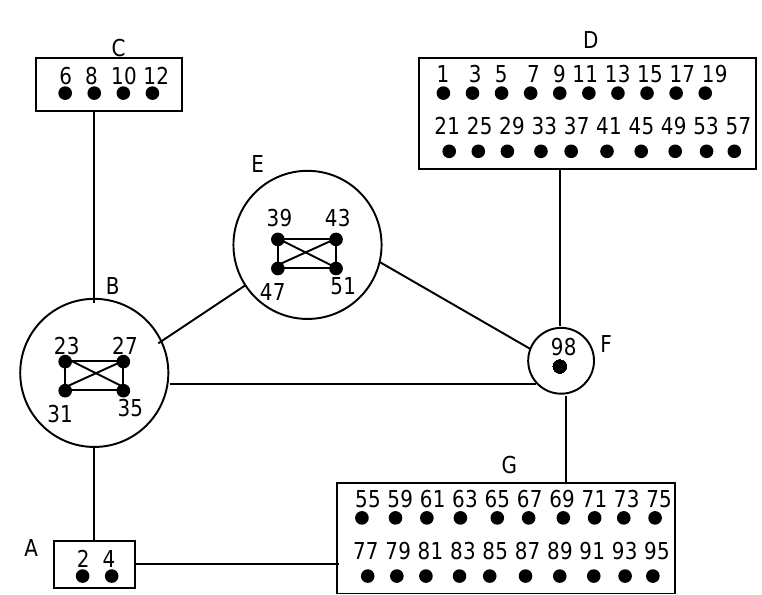
Figure 1. Depicts one example of Theorem 2 for p = 5 and q = 2.